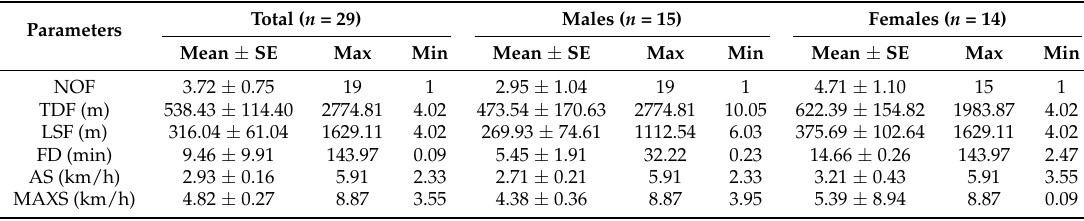
Table 7. Summary of flight parameters for M. galloprovincialis